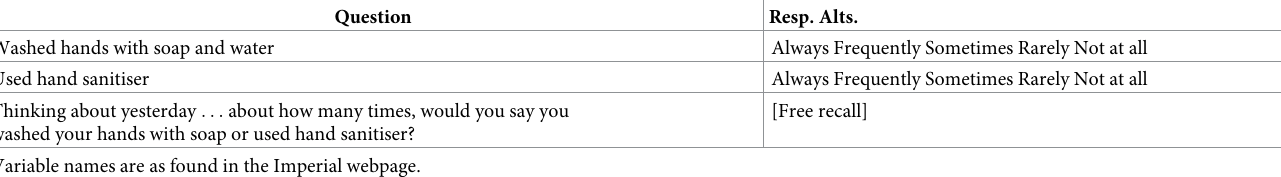
Table 2. Vague quantifier and free recall hand washing/santizing questions from the Imperial data set.